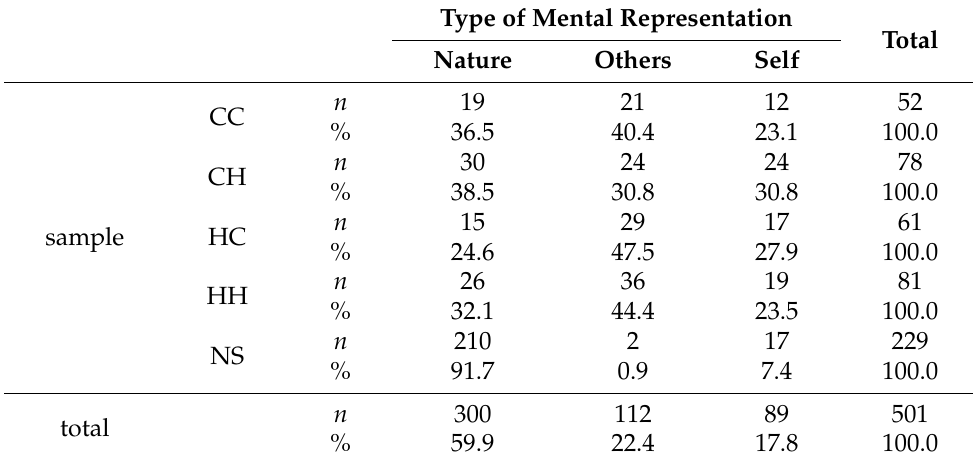
Table 5. Contingency table audio sample, type of mental